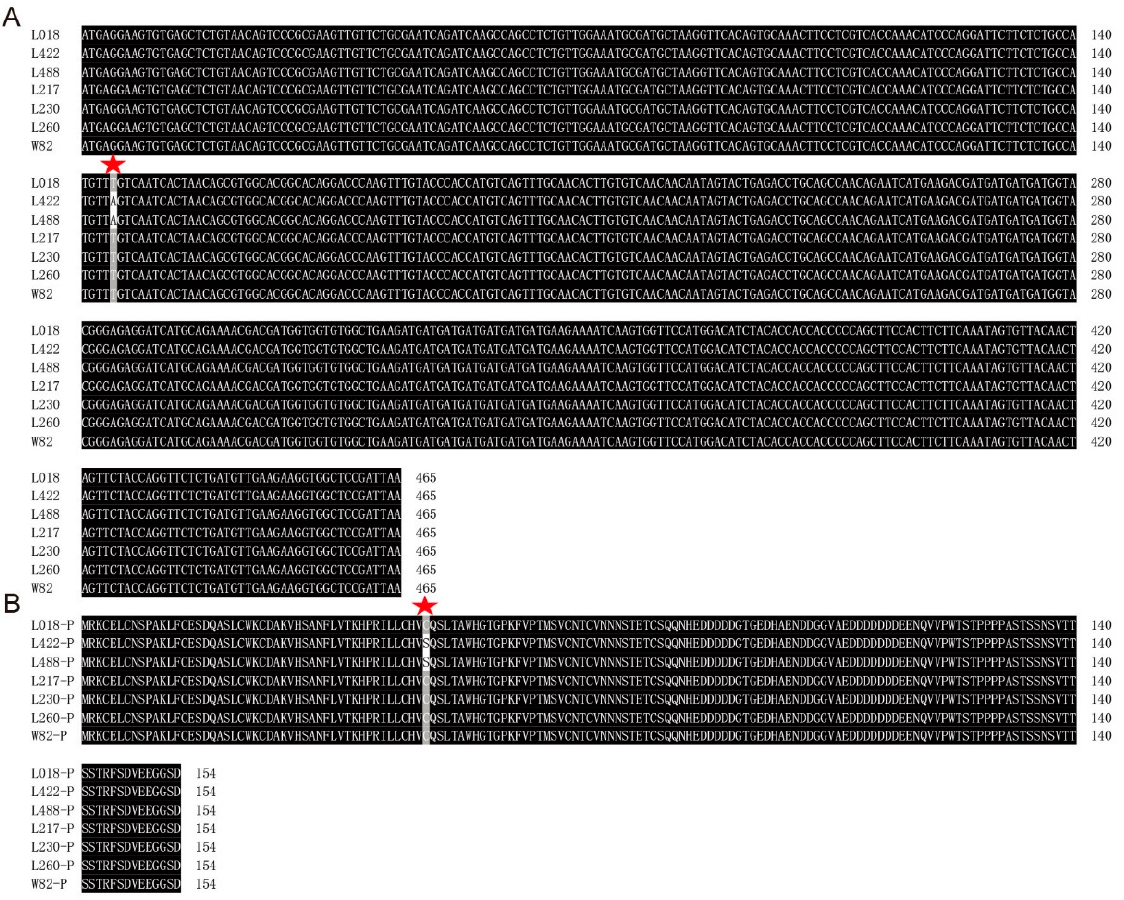
Figure 8. Nucleotide sequence and amino acid sequence alignment of Glyma.13g248000 in seed-flooding tolerant (L018, L422, and L488) and sensitive (L217, L230, and L260) genotypes. ( A ) The nucleotide sequence alignment. ( B ) Amino acid sequence alignment. W82 (William82), represents the reference genome of W82 ( Glycine max ).